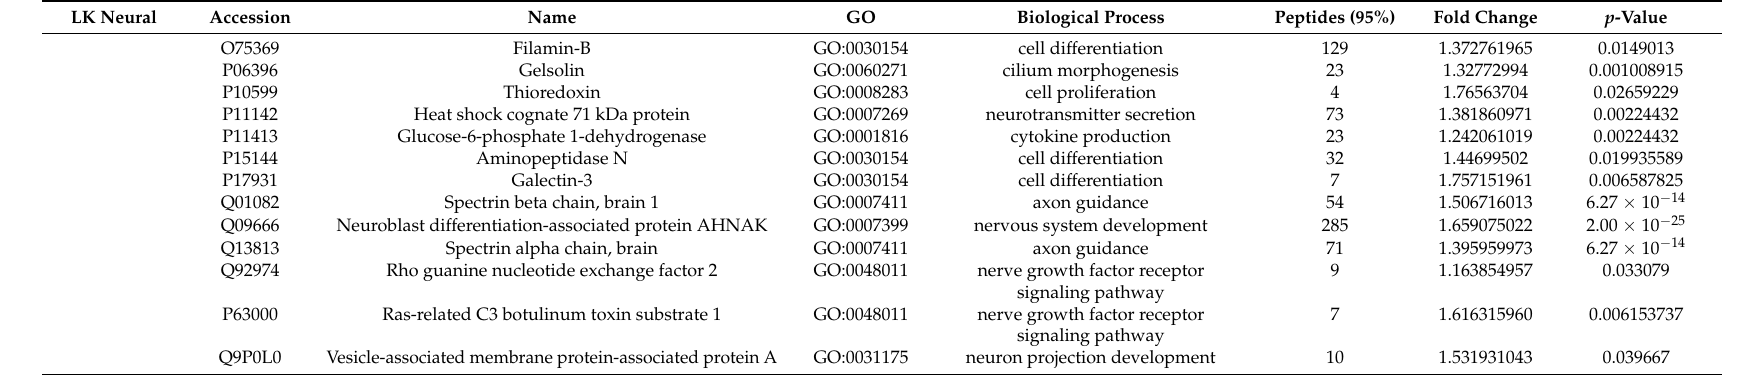
Table 3. Summary of biologically and statistically significant up-regulated neural-related proteins identified in iTRAQ of hADSCs treated with LK. LK